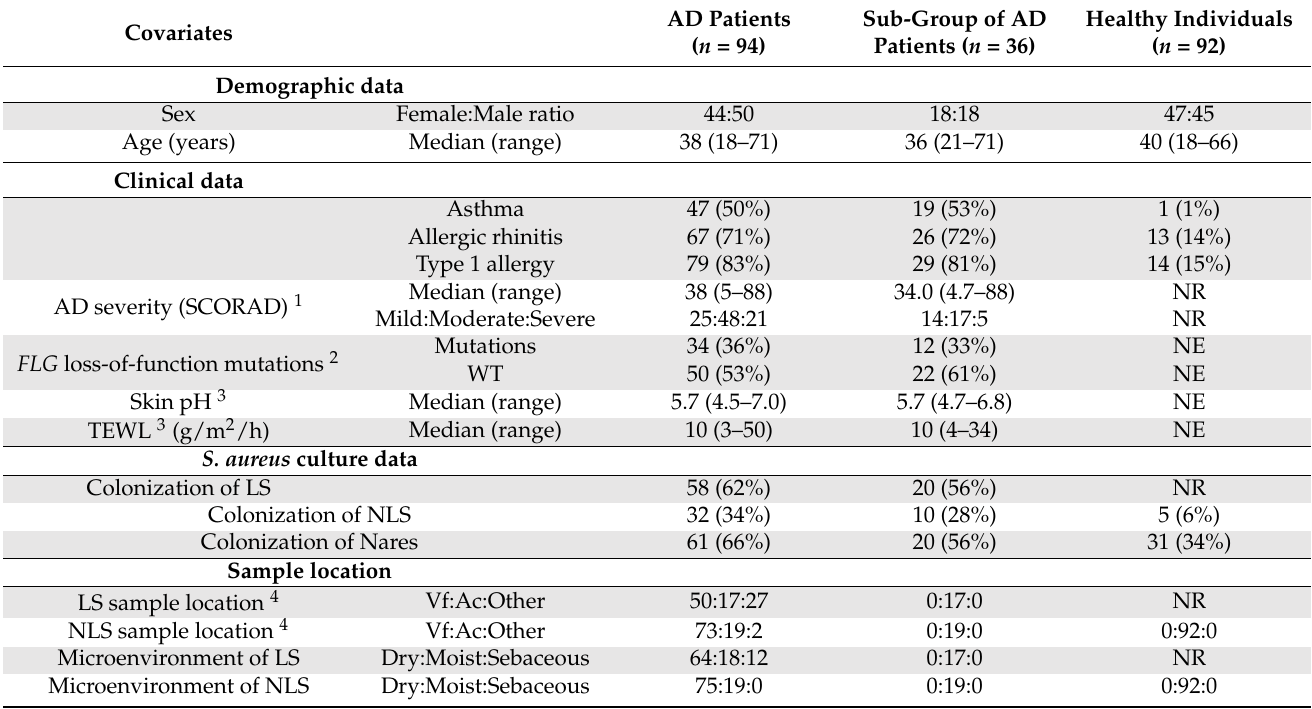
Table 1. Description of study